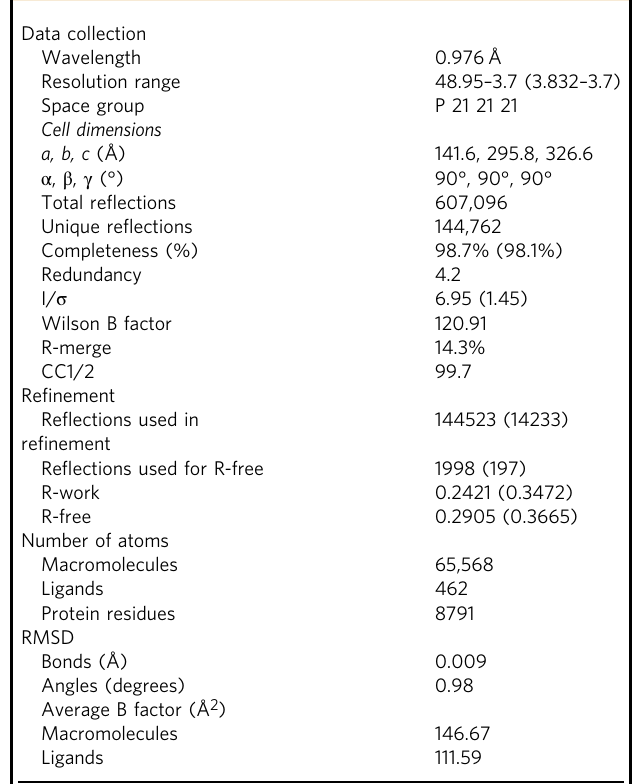
Table 1 Cryo-EM data collection, re fi nement, and validation statistics.